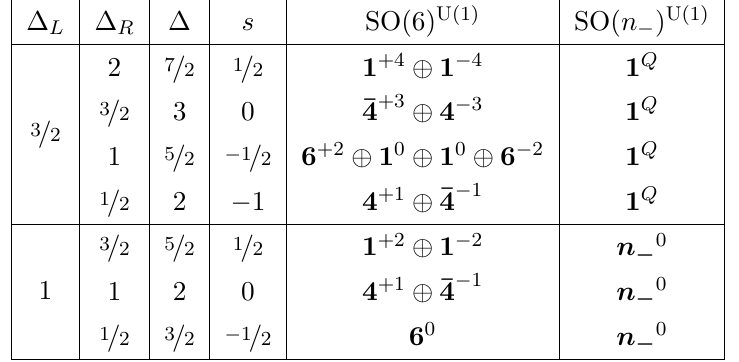
1 ; 1) solution with diagonal embedding (2.21a) with gauge j